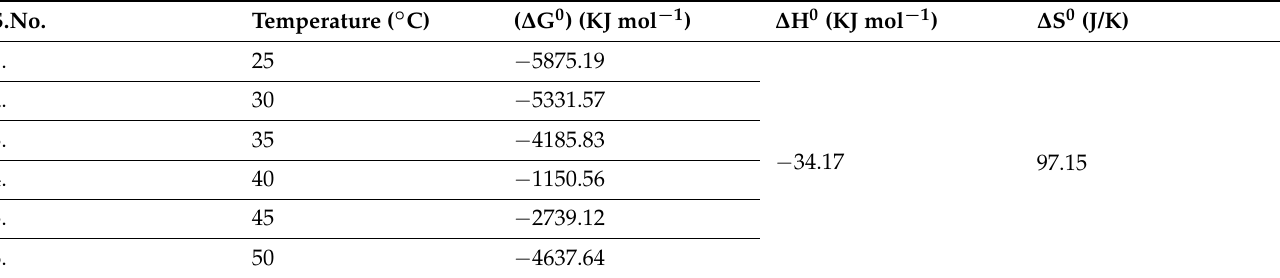
Table 4. Thermodynamic variables for PB dye adsorption by